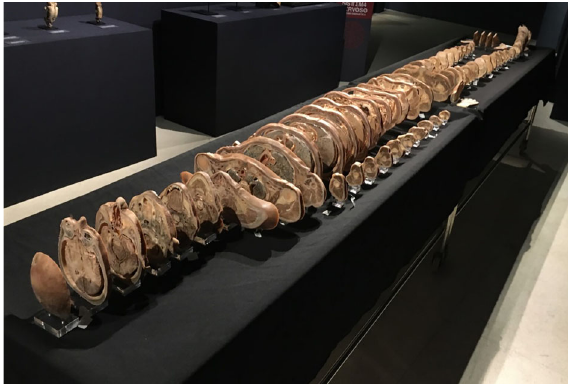
Figure 7. Plastinated specimen "tomography" on display at the Museum of Life Sciences